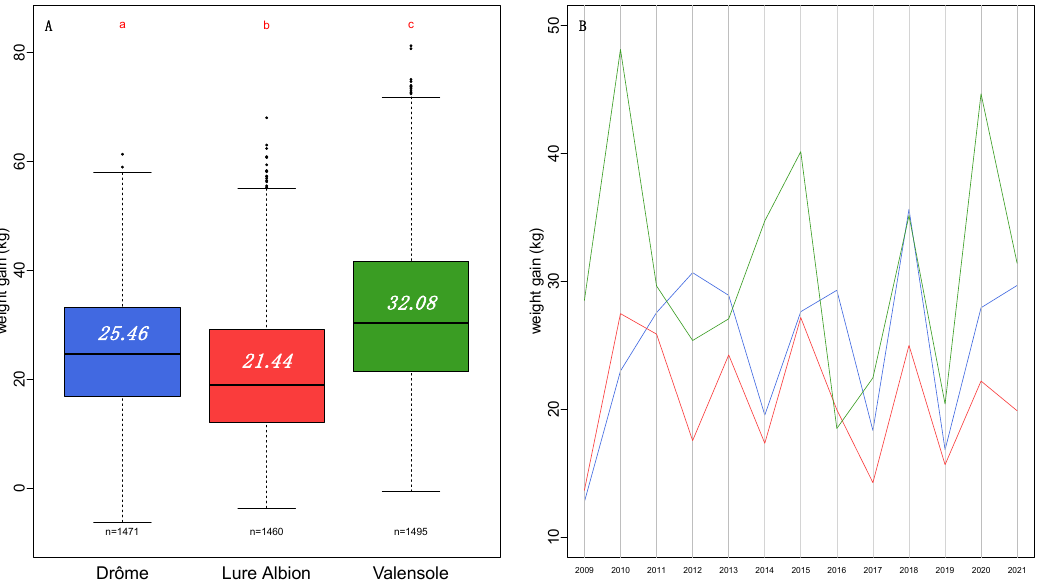
Figure 3. ( A ) Total weight gain per region across the 13-year survey. Red letters result from a pairwise Student test ( p -value < 0.05). Number in each box plot is the average total weight gain for that region. Number “n=” below each box plot is the number of hives surveyed for that region. ( B ) Average annual variation in the average total weight gain for the three regions (blue = Drôme; red = Lure Albion; green = Valensole).